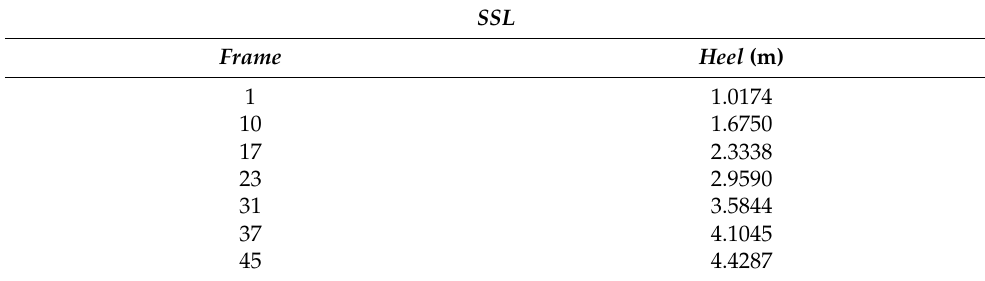
Table 1. Tabulated 2-dimensional sample array of 𝑆𝑆𝐿 .